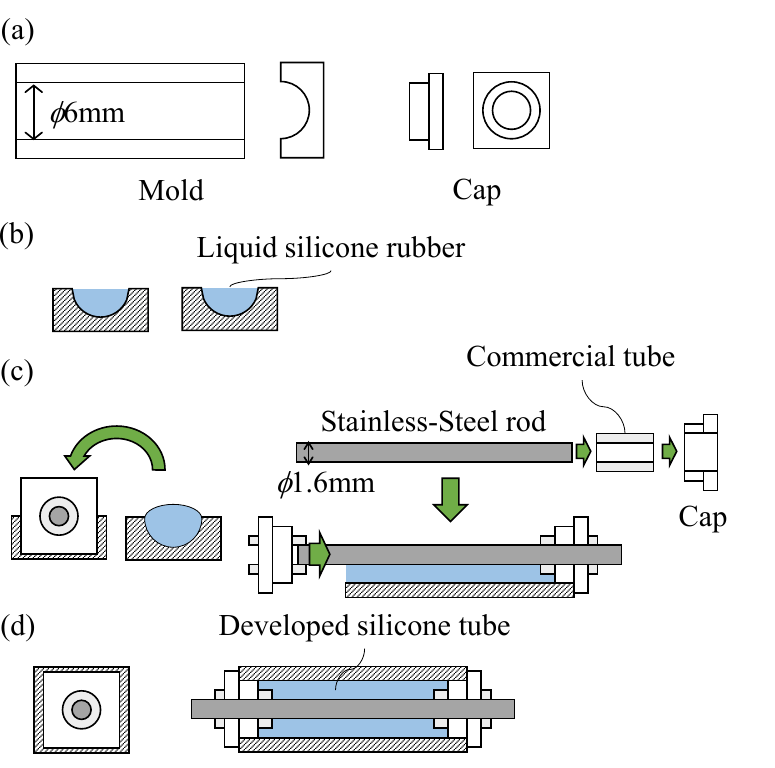
Figure 7. Molding procedure, where ( a – d ) show overview of molds and caps, liquid silicone which